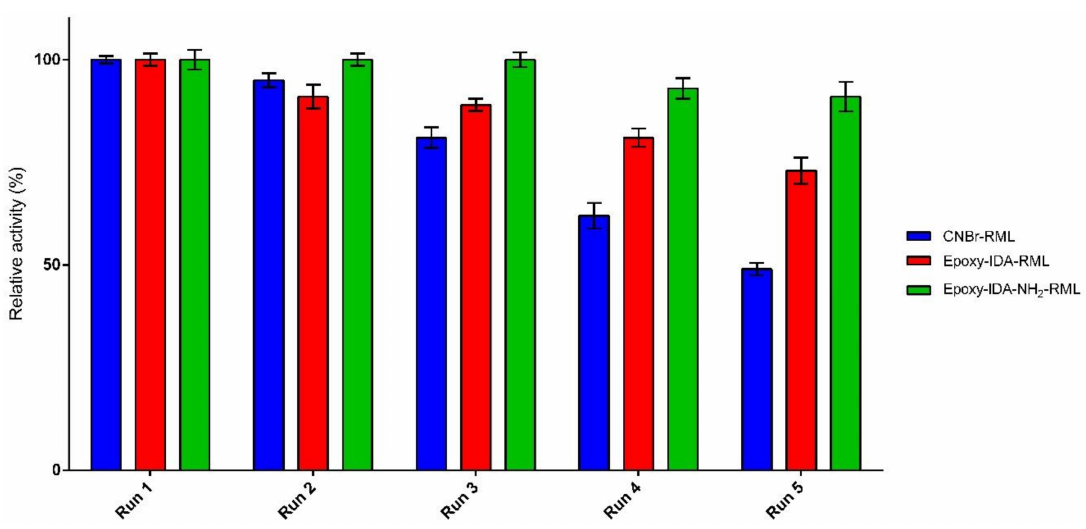
Figure 4. Recyclability of immobilized preparations in fish oil